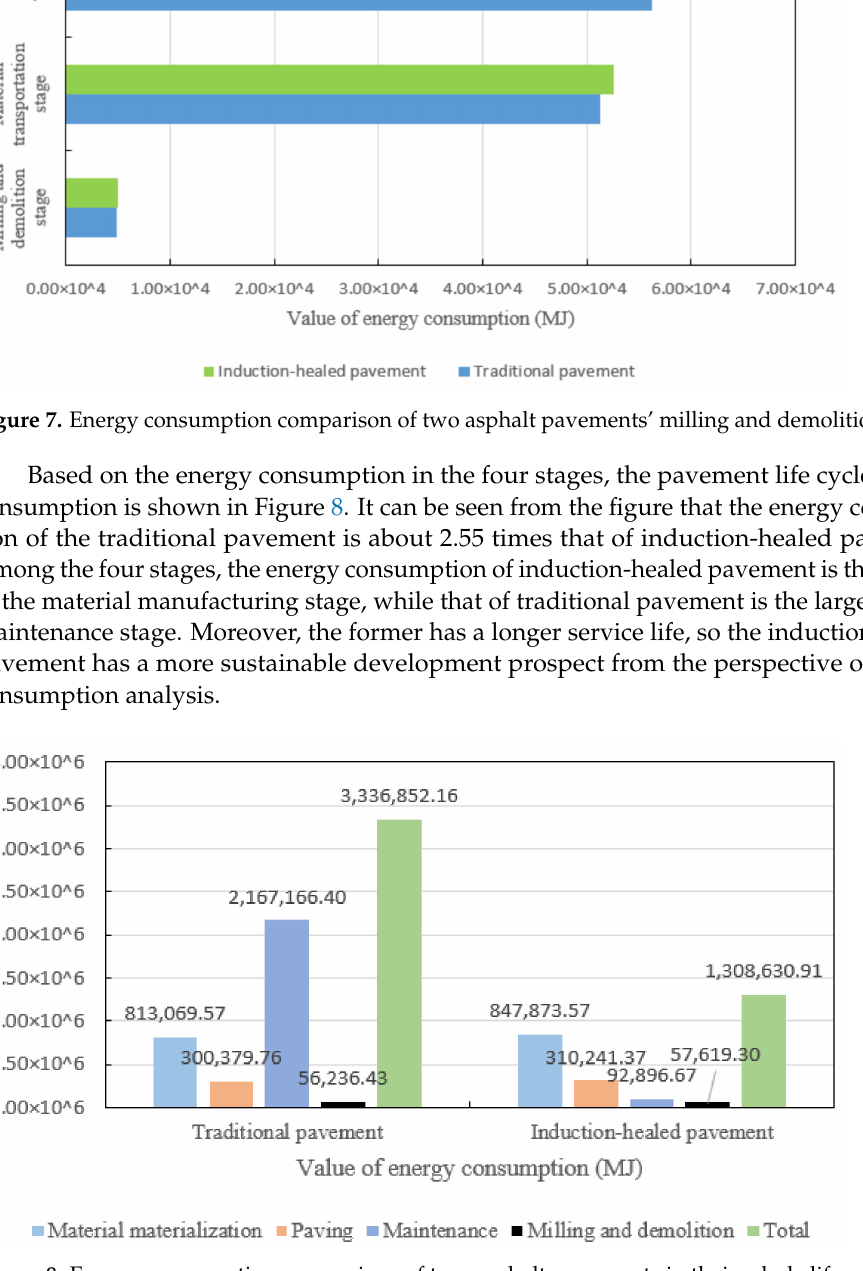
Figure 8. Energy consumption comparison of two asphalt pavements in their whole life